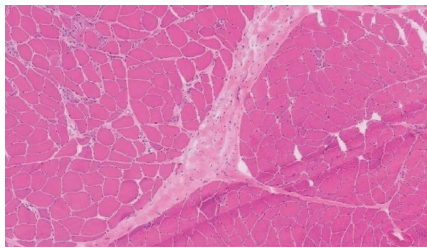
Figure 2: Right biceps muscle biopsy with hematoxylin and eosin staining showing necrotizing myopathy with muscle fber necrosis and regeneration without